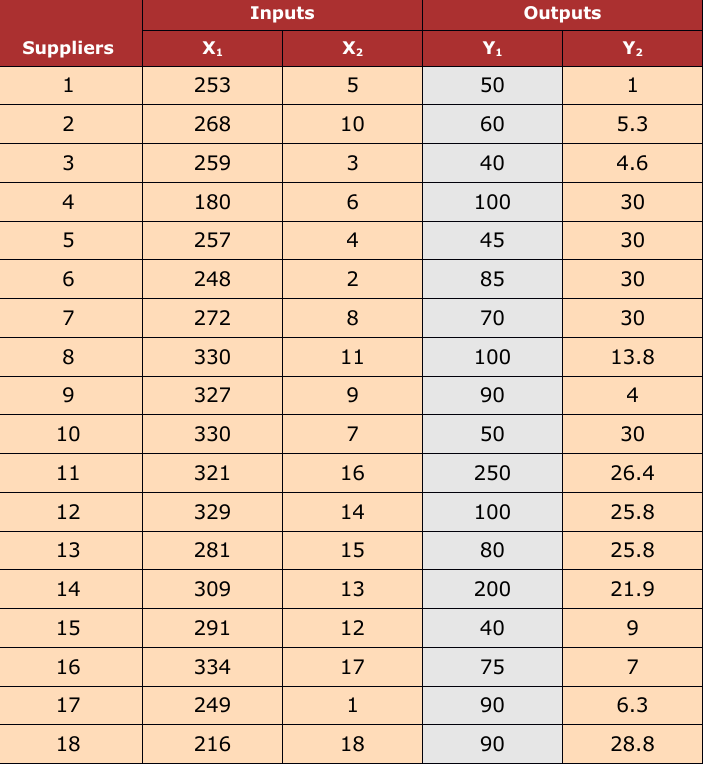
Table 1. Original values for α =